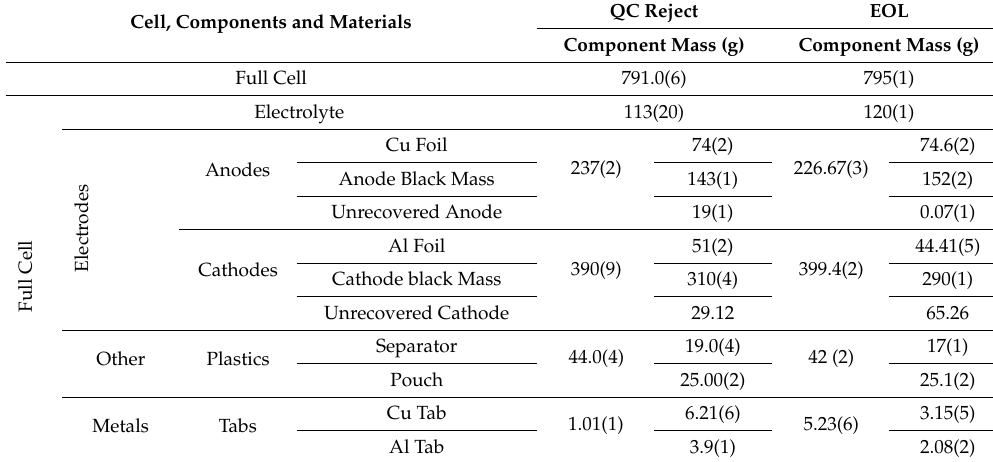
Table 1. Summary of tear down and reclaimed masses of cell components from a QC rejected cell and EOL.